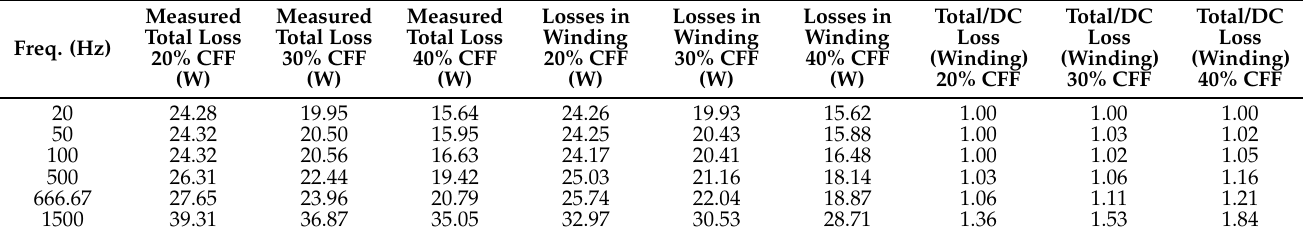
Table 6. Comparison of losses in the motorettes with varied copper filling